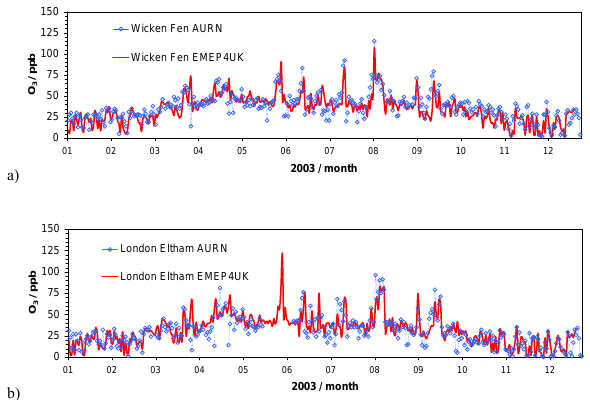
Fig. 3. Mid-afternoon (14:00–15:00) hourly mean surface ozone (ppb) for each day of 2003 (modelled, red; measured, blue) at: (a) Wicken Fen and (b) London Eltham (some missing data in the ob- Figure 3: Mid-afternoon (14:00-15:00) hourly mean surface ozone (ppb) for each day of 2003 servations in May and June). (modelled, red; measured, blue) at: a) Wicken Fen and b) London Eltham (some missing data in the observations in May and June).